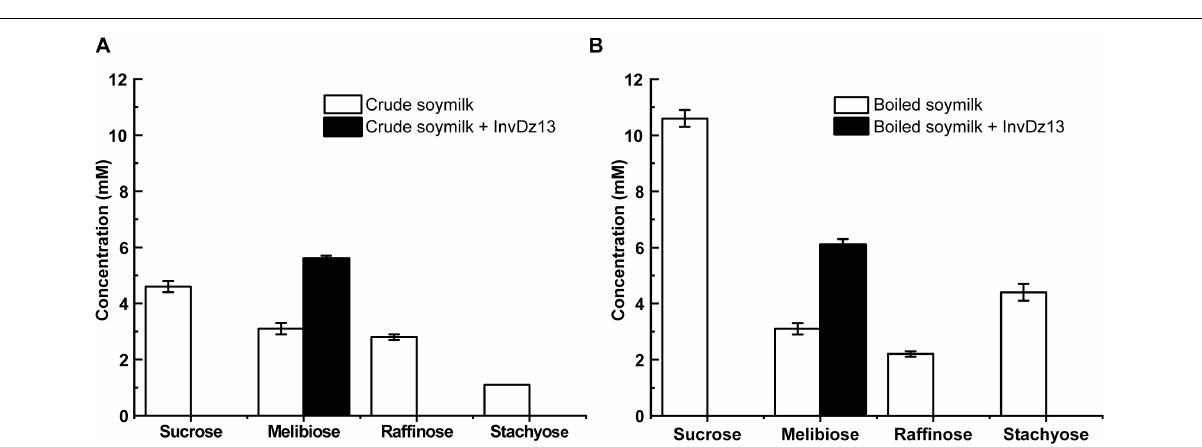
FIGURE 4 | Treatment of soymilk with InvDz13. The crude soymilk (A) and boiled soymilk (B) were treated with 10 U/mL InvDz13 at 30 ◦ C for 1 h. Then the crude soymilk was further boiled for 15 min. Each soymilk sample was mixed with 70% ethanol (1:1, v/v) for 5 min, centrifuged at 20,000 × g to discard proteins, and determined using HPLC to detect the saccharides. Values are the means of three replication ± standard